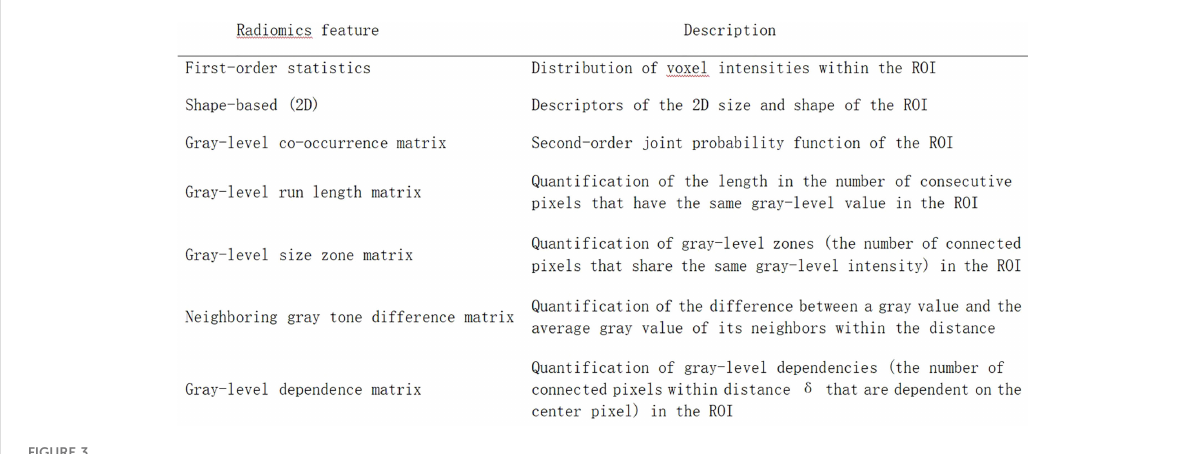
FIGURE 3 List of radiomics feature classes with descriptions from the PyRadiomics